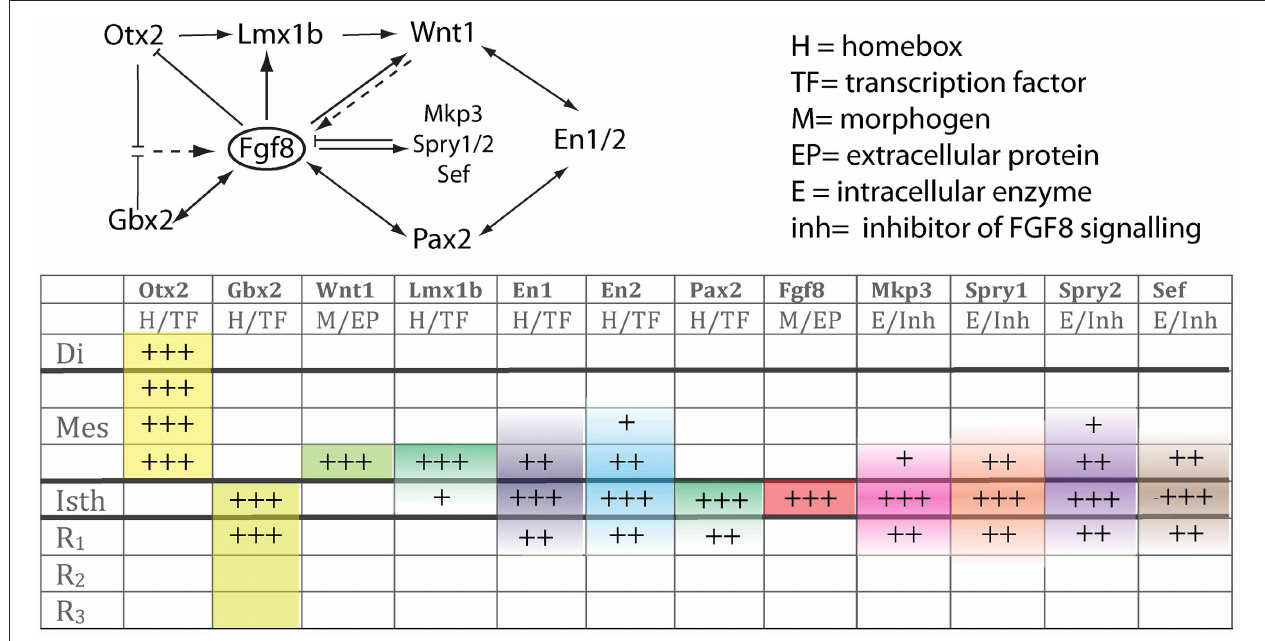
FIGURE 4 | The upper scheme represents the functional interaction (induction/inhibition) of genes that, together with Fgf8, are involved in the molecular maintenance of isthmic region at E9.5. The table below